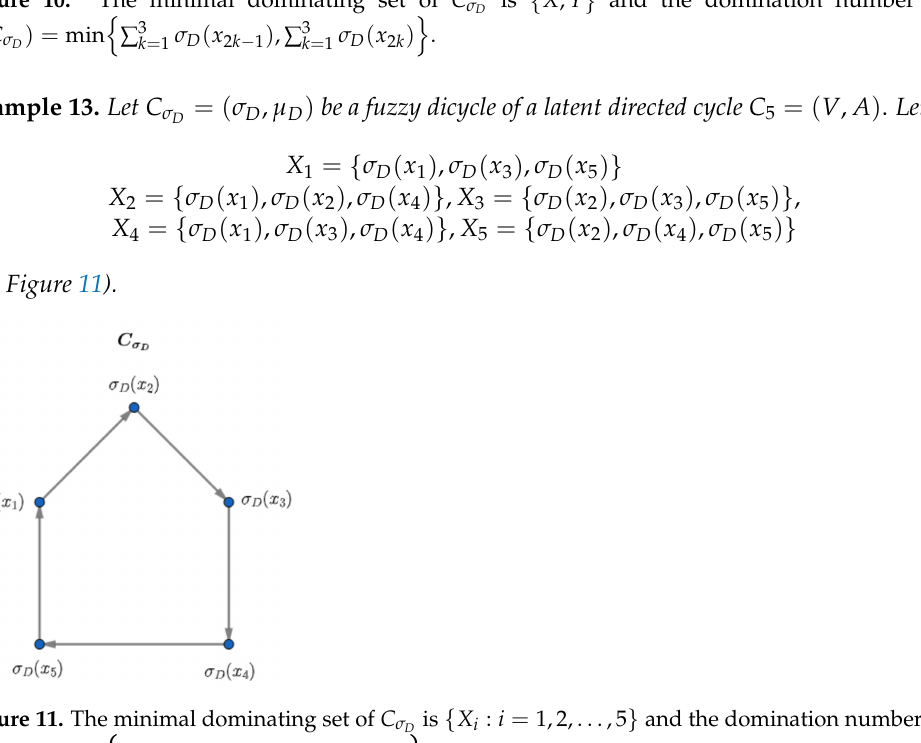
is { X i : i = 1,2, . . . ,5 } and the domination number is D